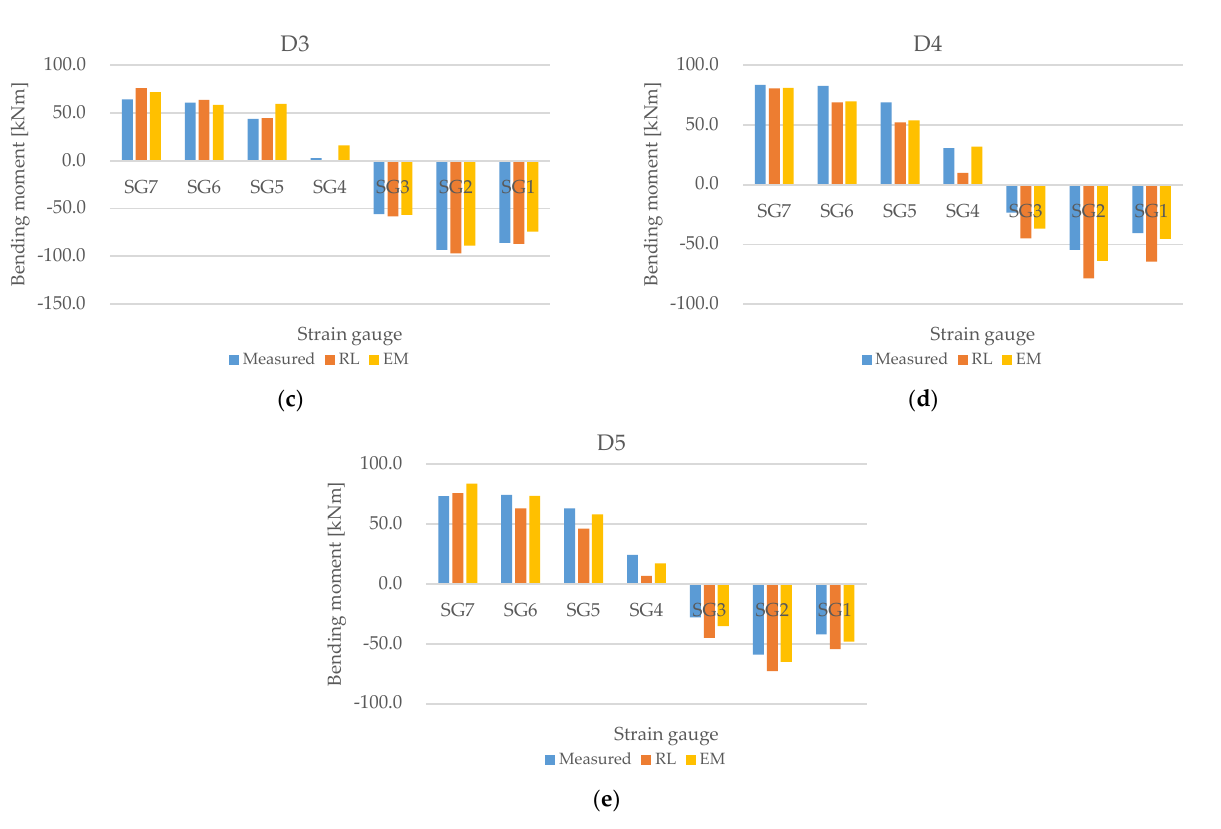
Figure 25. Comparison of bending moment prediction of ( a ) D1, ( b ) D2, ( c ) D3, ( d ) D4, and ( e ) D5.